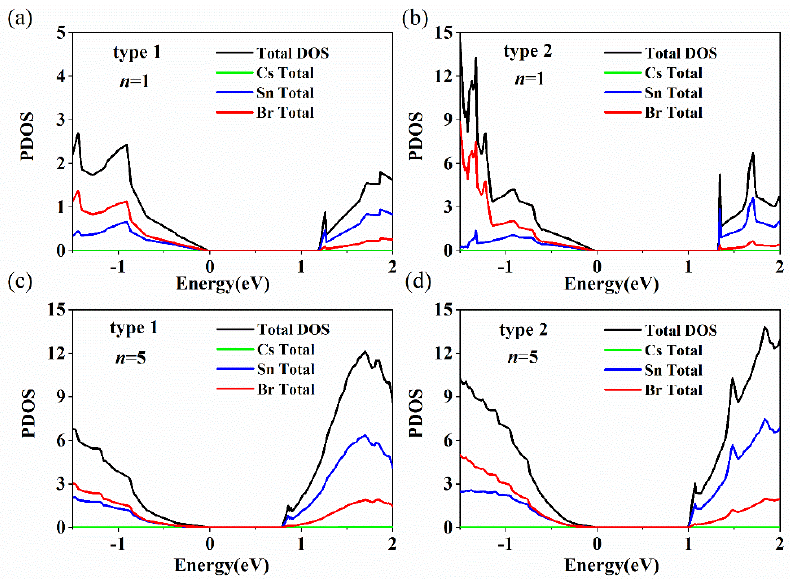
Figure 5. Calculated DOS for Cs n +1 Sn n Br 3 n +1 and Cs n Sn n +1 Br 3 n +2 with n = 1 and 5. The arrow points to the peaks of Type 1 and Type 2 at n = 1. The green, blue, red, and black lines represent Cs TDOS, Sn TDOS, Br TDOS and TDOS, respectively. The models are ( a ) Cs n +1 Sn n Br 3 n +1 ( n = 1), ( b ) Cs n Sn n +1 Br 3 n +2 ( n = 1), ( c ) Cs n +1 Sn n Br 3 n +1 ( n = 5) and ( d ) Cs n Sn n +1 Br 3 n +2 ( n = 5).